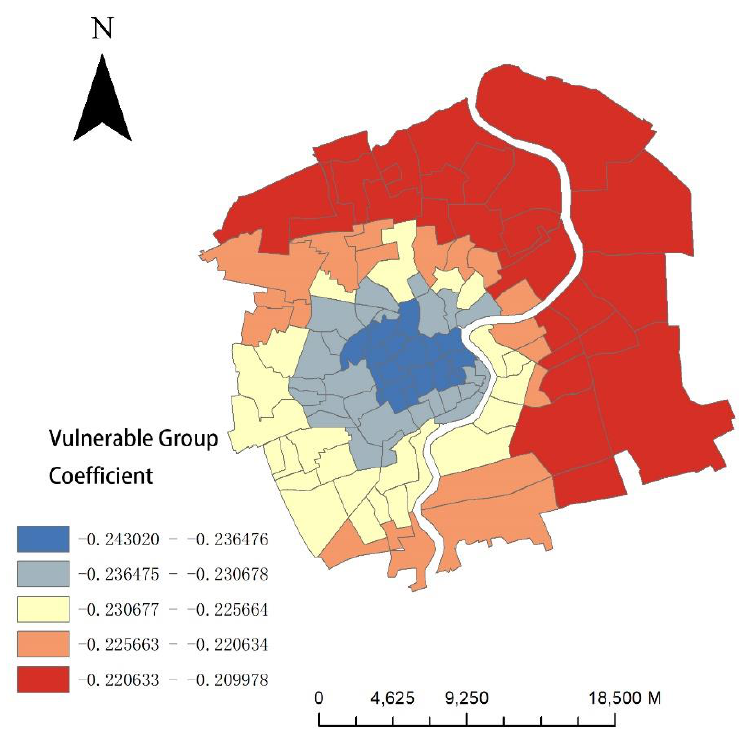
Figure 12. Vulnerable-group coefficients at each county or jiedao.